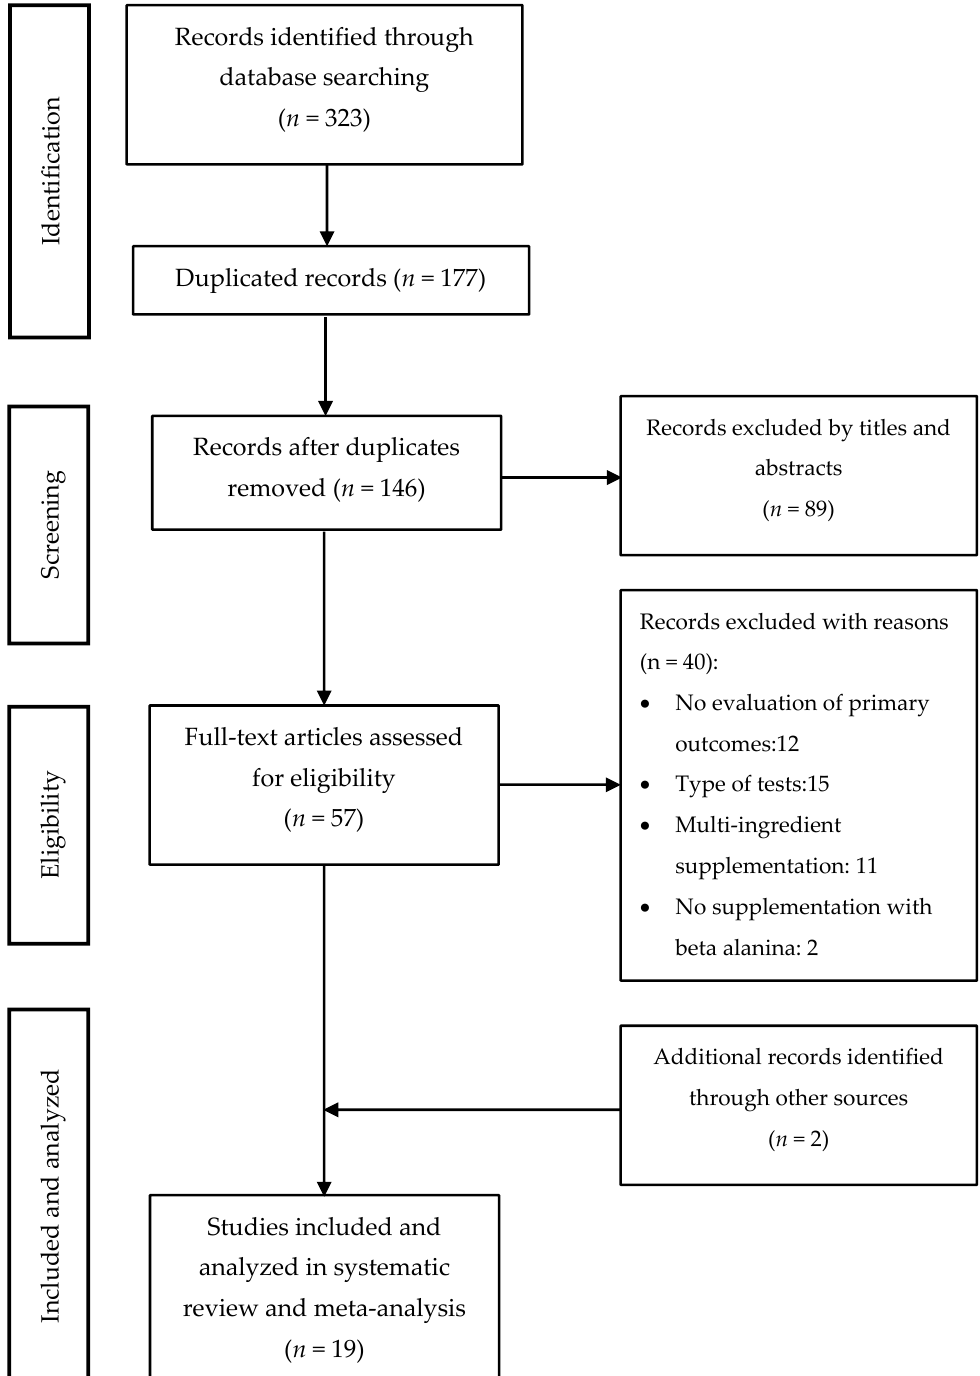
Figure 4. Studies included in the systematic review and meta ‐ analysis.